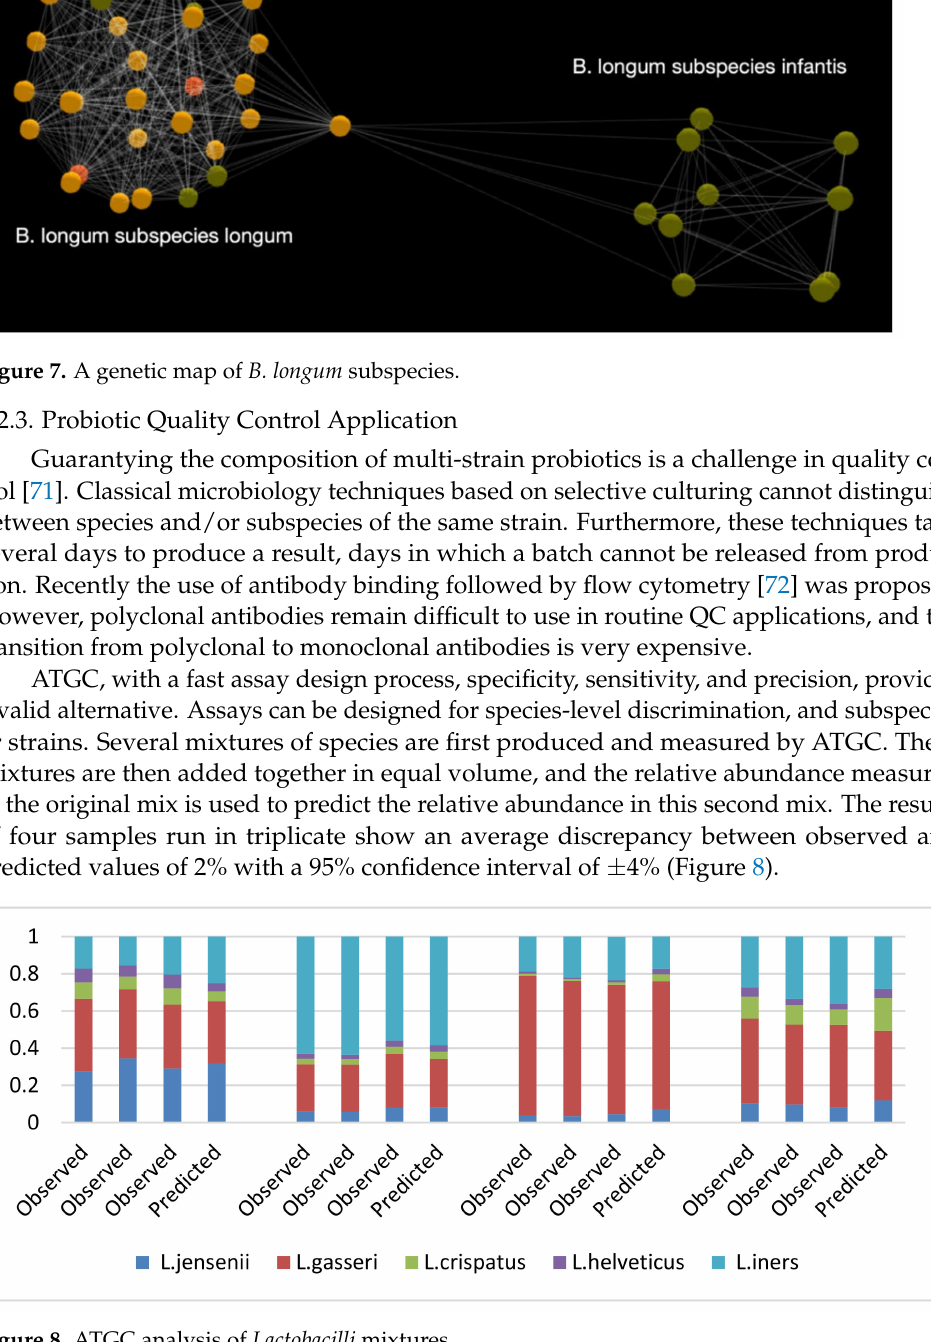
Figure 8. ATGC analysis of Lactobacilli